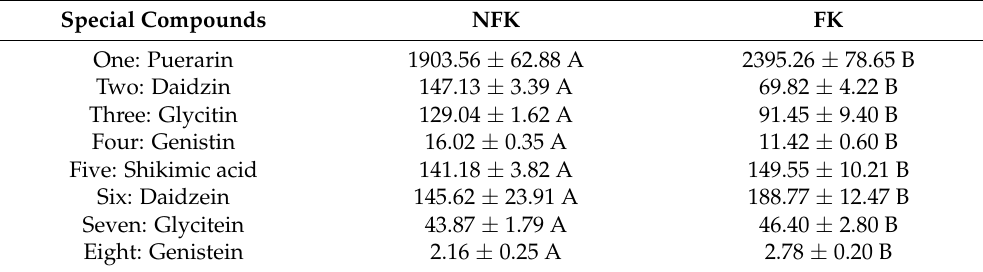
Each value represents the mean ± S.D. ( n = 3). Means being different capital letters (A,B) within a row under the same fermentation condition showed a significant difference ( p < 0.05) between NFK and FK.